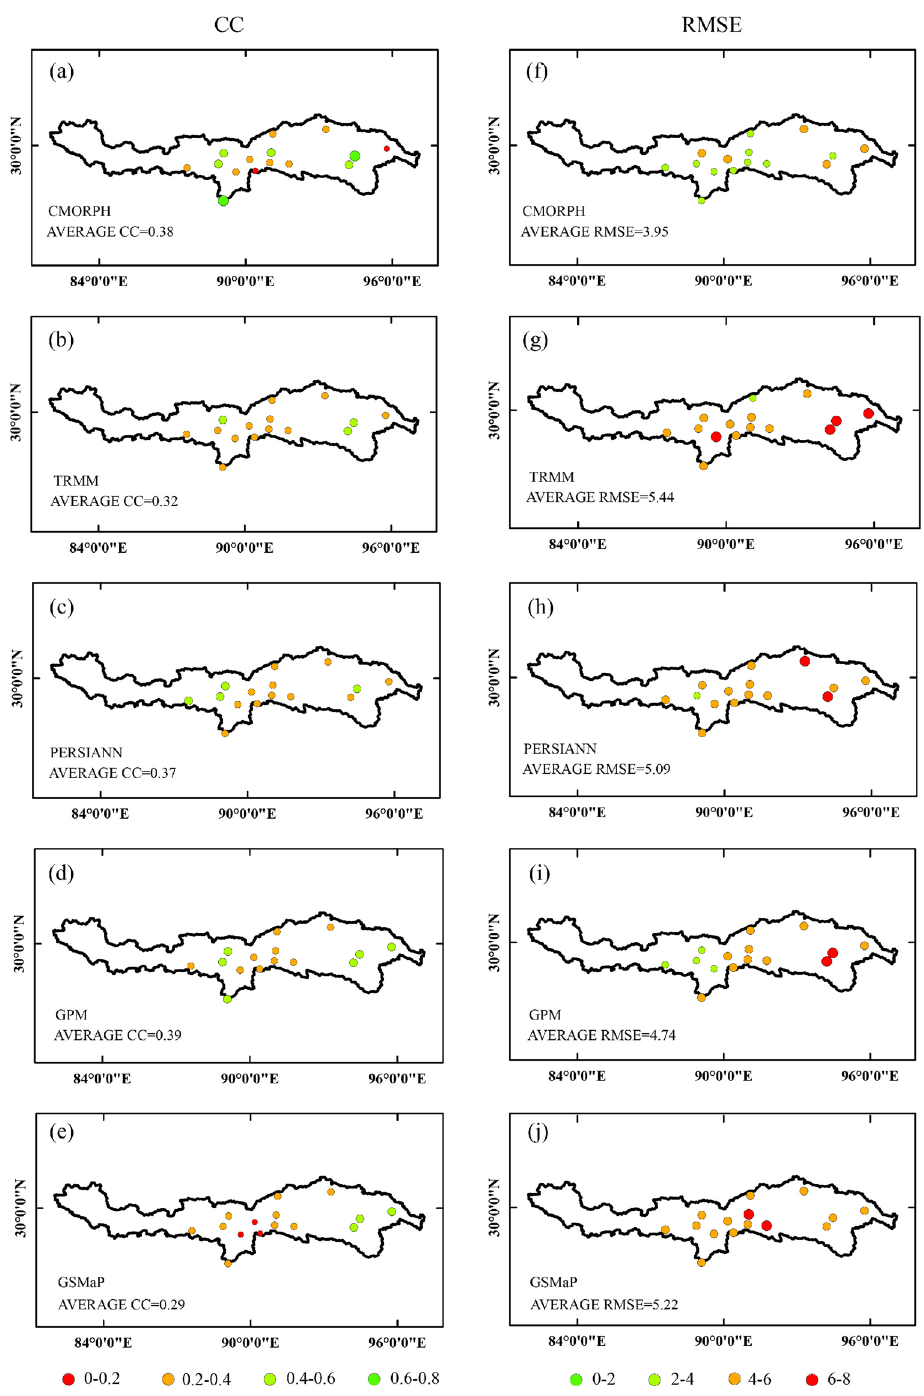
Figure 3. Spatial distribution of CC and RMSE between SPPs and gauged